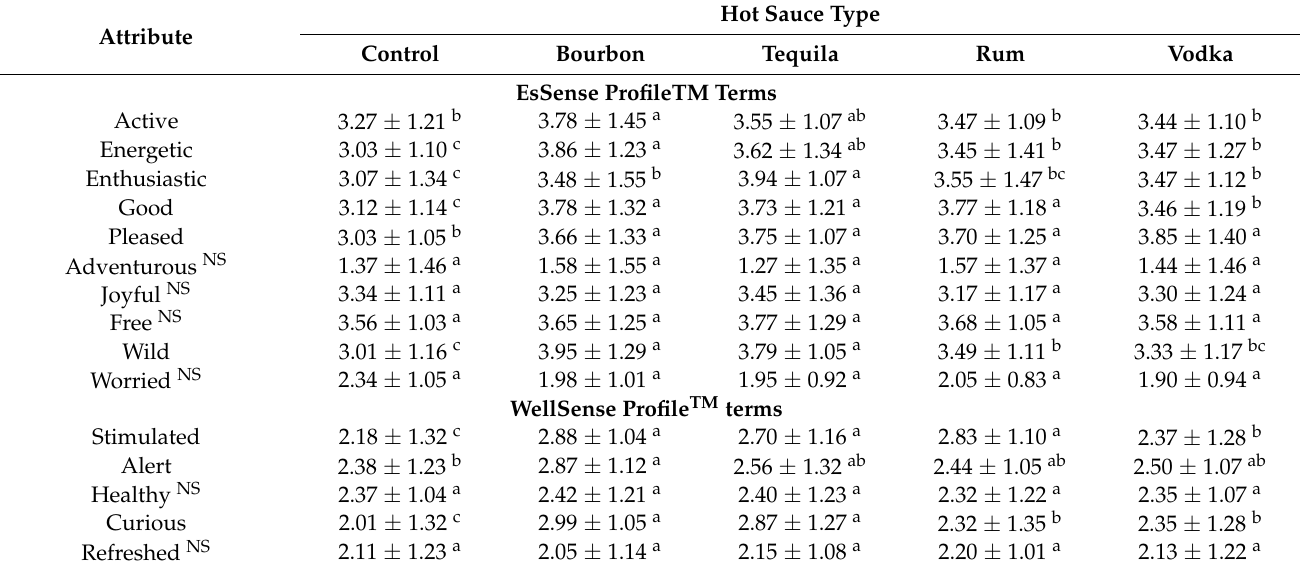
Table 4. Mean consumer emotions and well senses scores of hot sauces formulated with vinegar (control), tequila, bourbon, vodka, and